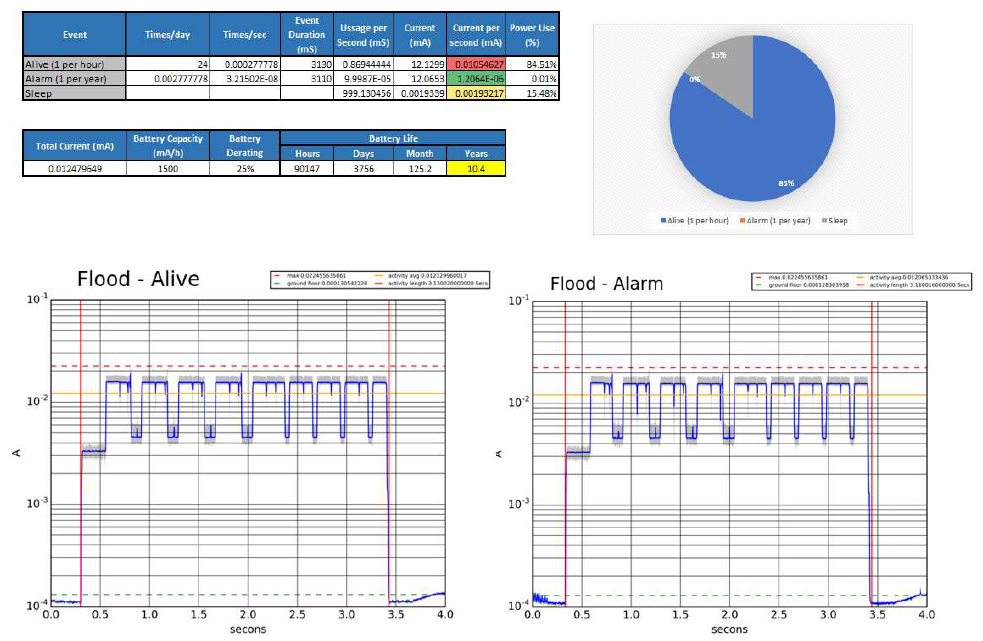
Figure 10. Detail estimation of the flood sensor battery life.